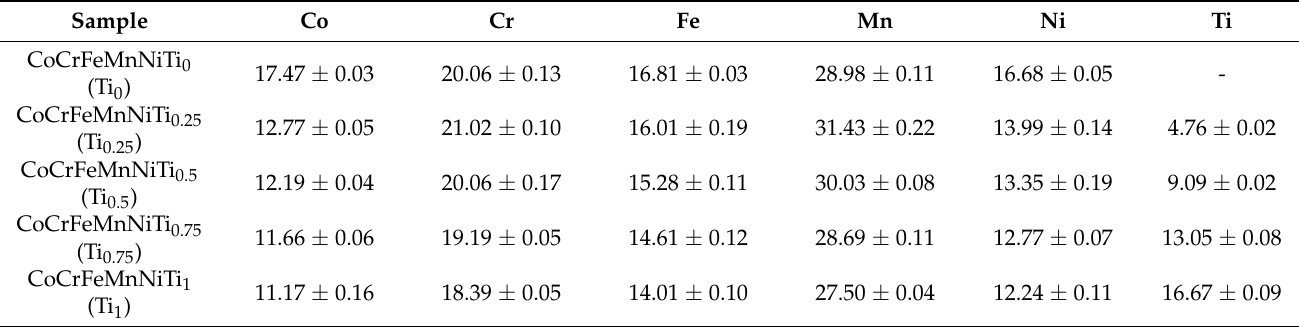
Figure 1. SEM morphology of the starting powders: ( a ) CoCrFeMnNi and ( b ) Ti. Table 1. Chemical composition of CoCrFeMnNiTi x (at.%).